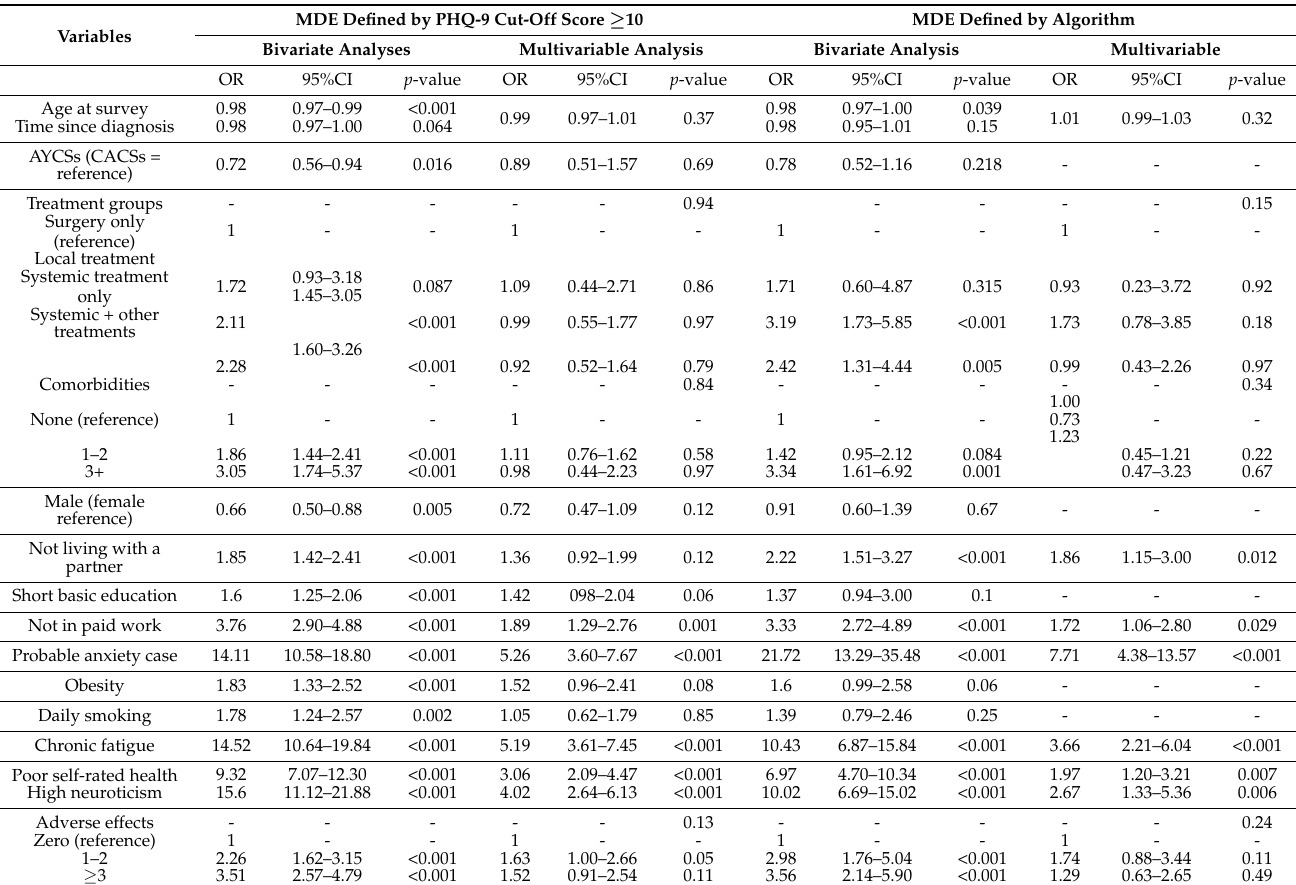
Table 3. Bivariate and multivariate logistic regression analyses of independent variables and possible MDE defined by the cut-off and the algorithm